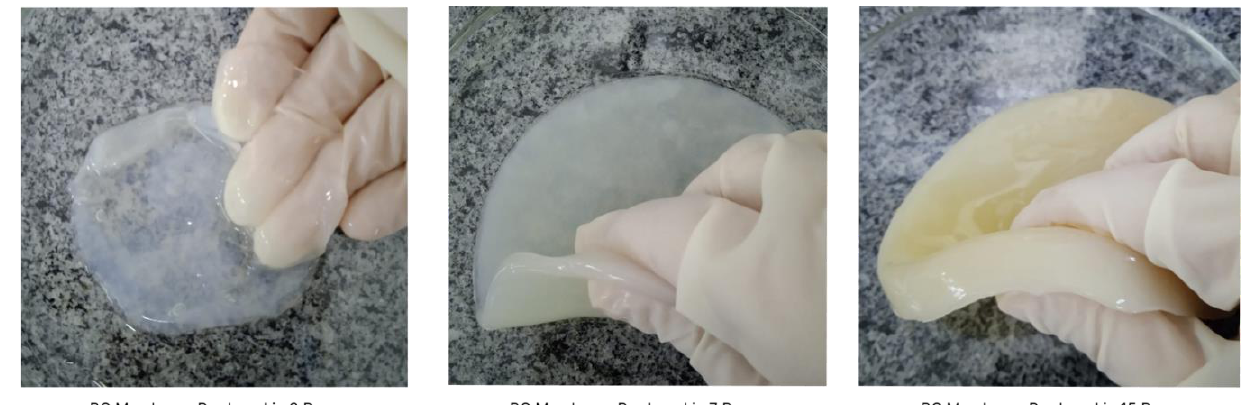
Figure 1. BC films produced after 3, 7 and 15 days.